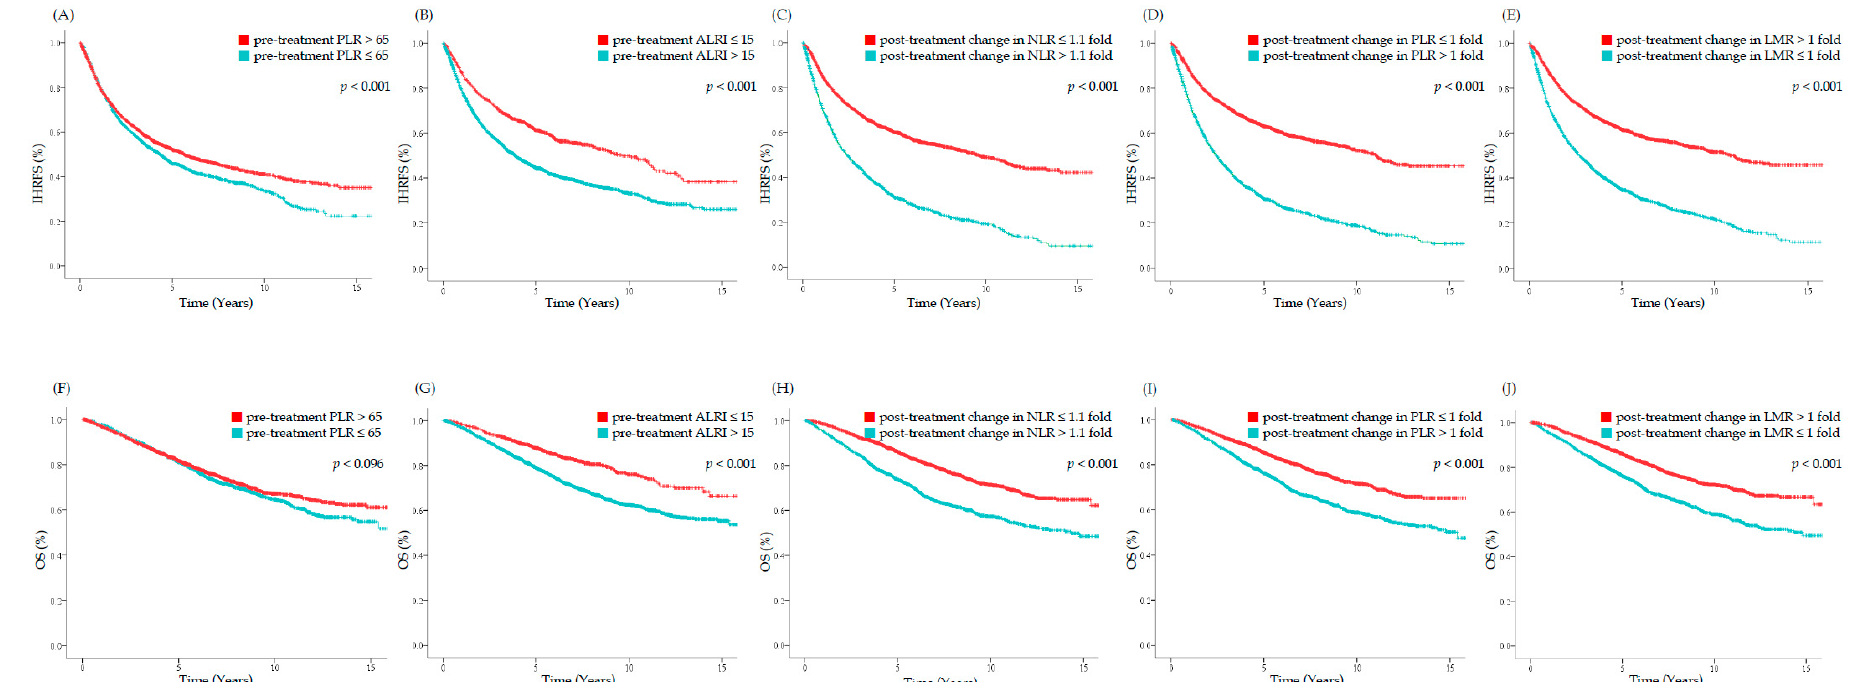
Figure 3. Kaplan–Meier curves of IHRFS and OS stratified by SIMs which showed prognostic significance to IHR: ( A – E ) IHRFS; ( F – J ) OS. IHRFS, intrahepatic recurrence-free survival; OS, overall survival; SIMs, systemic inflammatory markers; PLR, platelet-to-lymphocyte ratio; ALRI, aspartate-transaminase-to-lymphocyte ratio index; NLR, neutrophil-to-lymphocyte ratio; LMR, lymphocyte-to-monocyte ratio. Table 4. IHRFS and OS of patients categorized by SIMs.